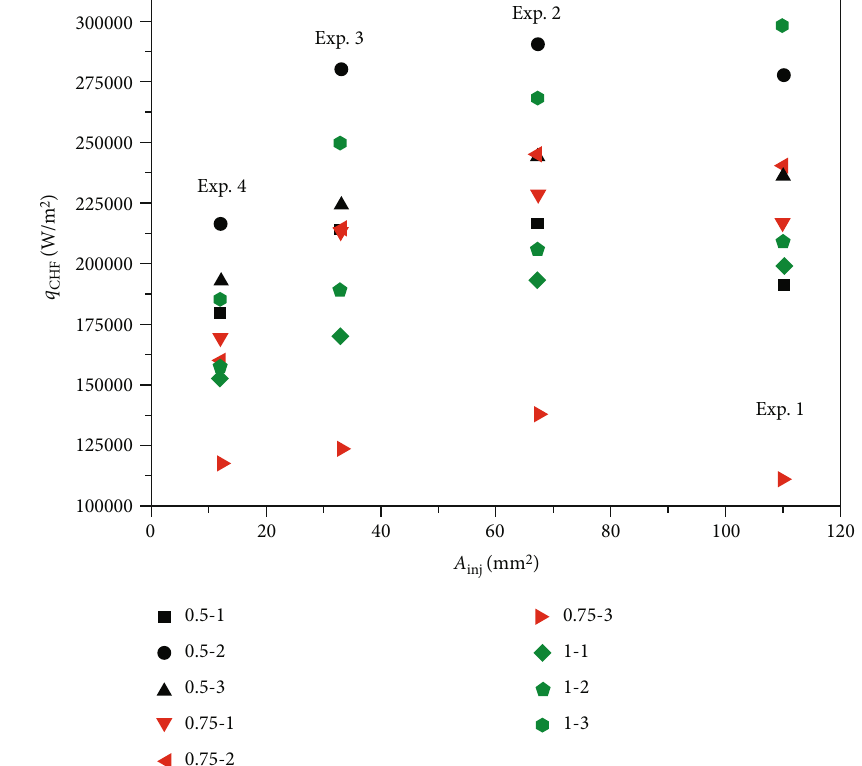
Figure 18: Experimental q